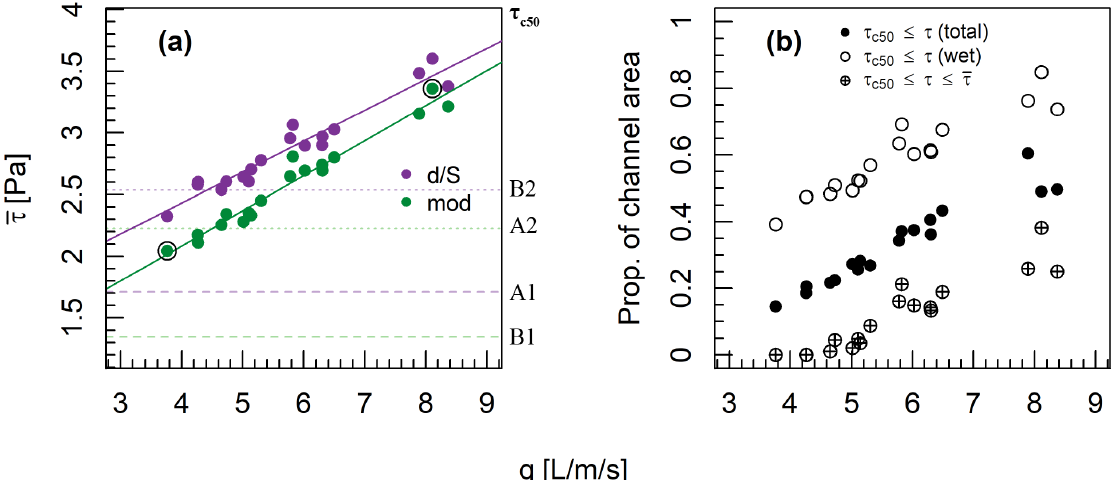
Figure 6. (a) Relationship between unit discharge q (calculated using wetted width) and mean shear stress ¯ τ using depth–slope product (RMSE = 0 . 097, r 2 = 0 . 93, p < 0 . 001) and modelled shear stresses (RMSE = 0 . 073, r 2 = 0 . 96, p < 0 . 001). Horizontal lines indicate fitted values of τ c50 , and circled points indicate channels with the highest and lowest shear stress used in Fig. 7b. (b) Relationship between unit discharge and the proportion of the wetted channel area ( d > 2 D 84 ) where τ > τ c50 using modelled shear stresses (i.e. approach B2), as well as the proportion of channel area where τ c50 < τ ≤ ¯ τ .